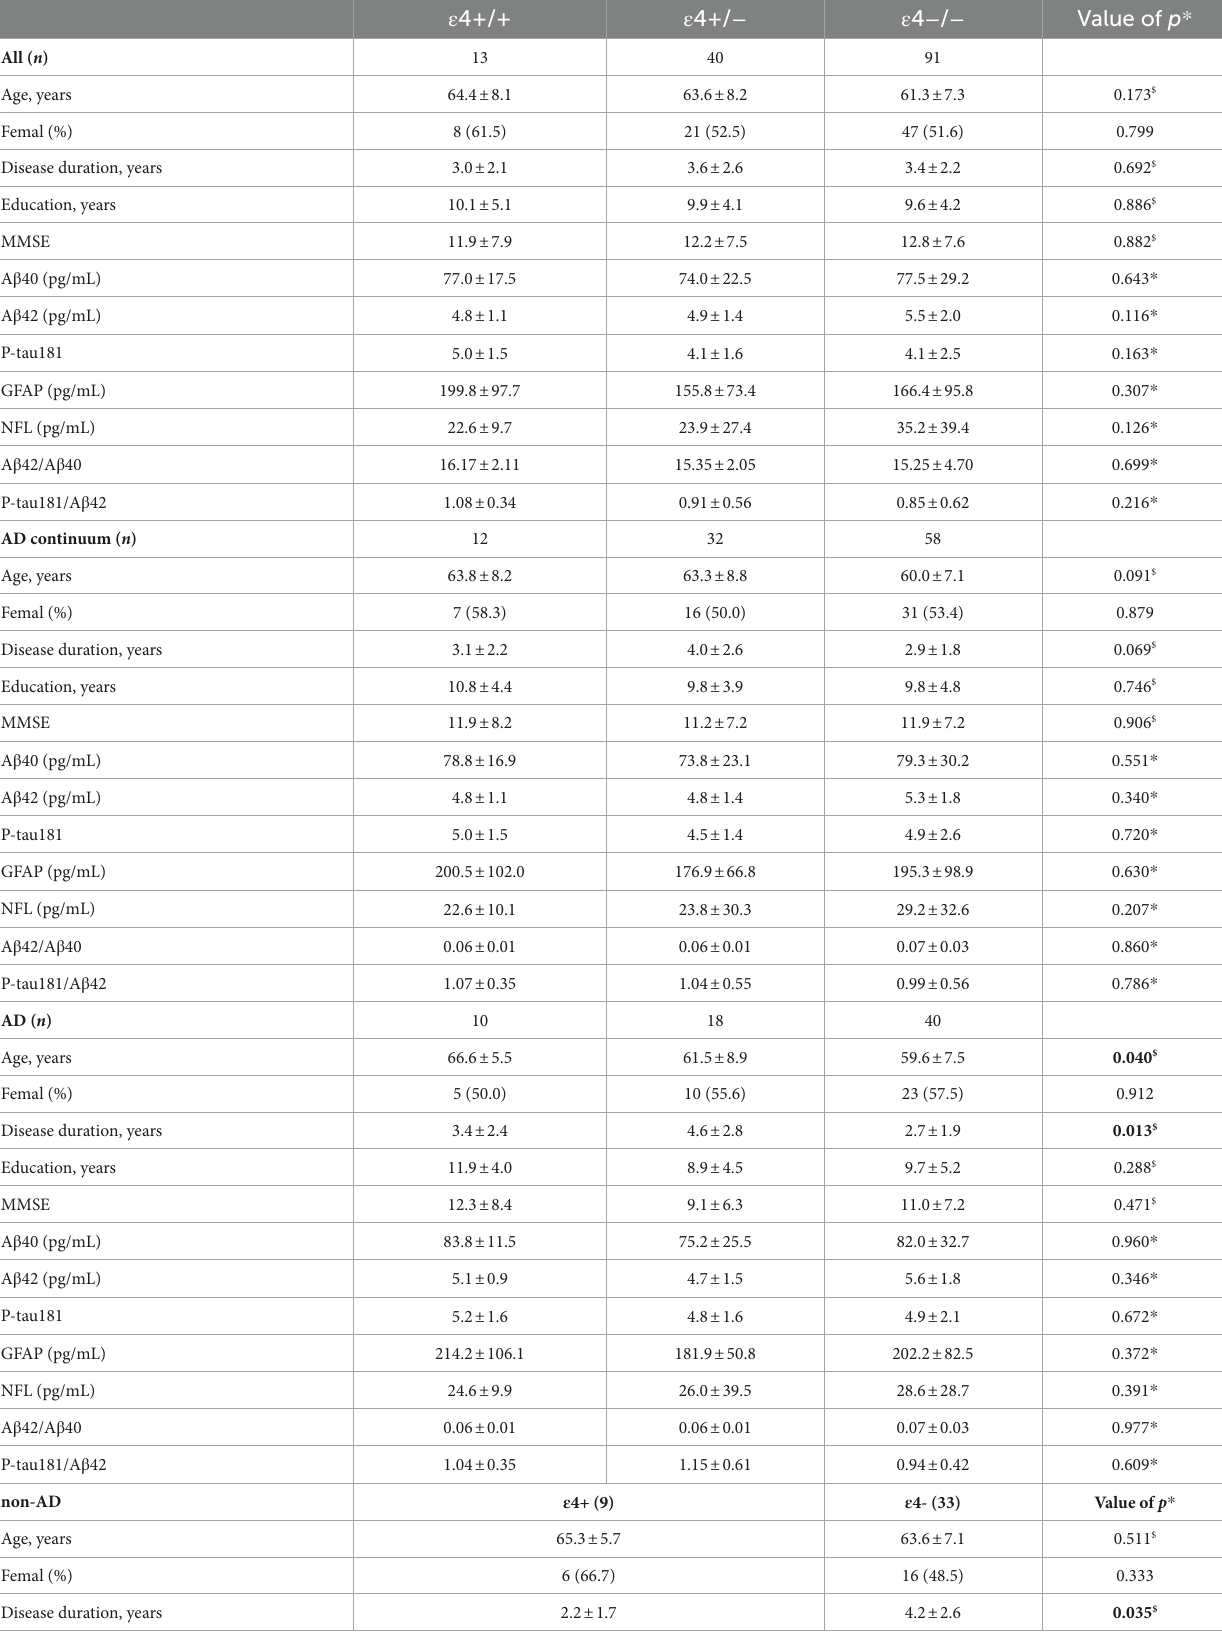
TABLE 2 Comparison of plasma biomarker levels of all patients, Alzheimer’s continuum, AD, and non-AD among the different ApoE ε 4 genotypes. ε 4+/+ ε 4+/ − ε 4 − /